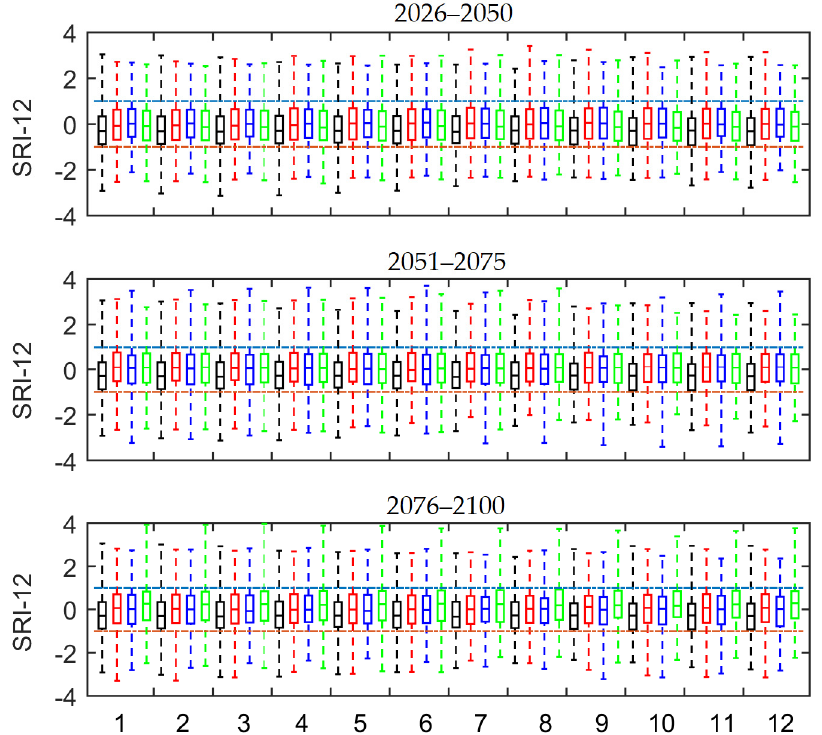
Figure 3. Projected SRI-12 for the near-, mid-, and long-term periods under the SSP1–2.6, SSP2–4.5, and SSP5–8.5 scenarios (black, red, blue, and green boxes represent the reference period, SSP1–2.6, SSP2–4.5, and SSP5–8.5 scenarios, respectively). Table 5. Changes in frequency (times) of SRI-12 relative to the reference period for the near-, mid-, and long-term periods under the SSP1–2.6, SSP2–4.5, and SSP5–8.5 scenarios.